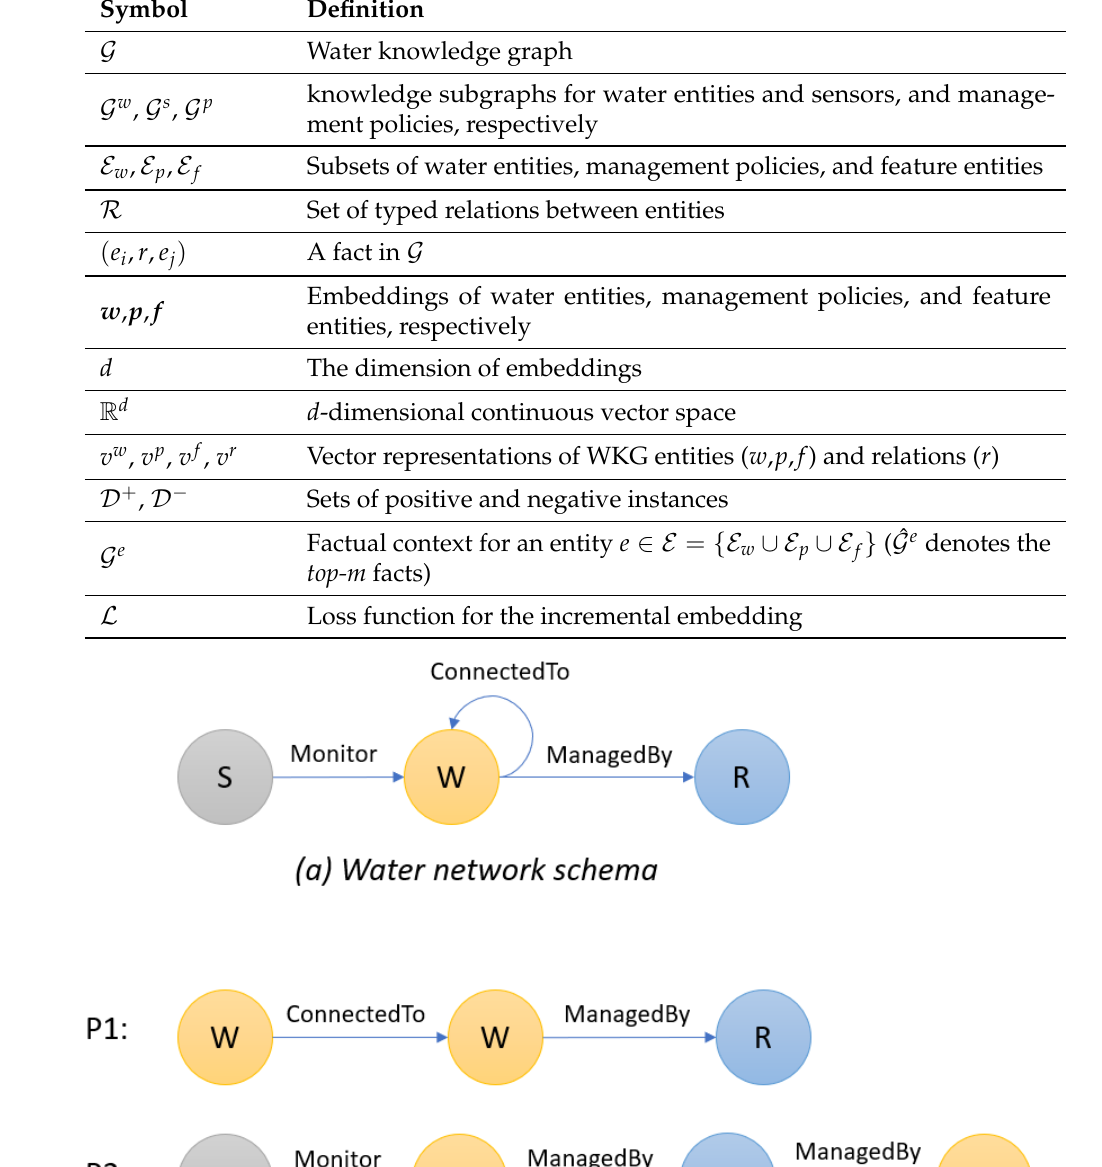
Table 4. Symbols and basic notations.